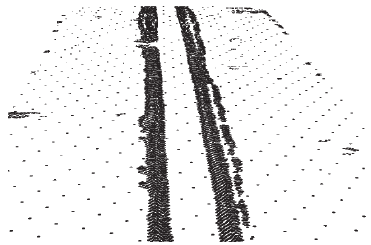
Fig. 4. The points selected for plane fitting under rms < 0.05